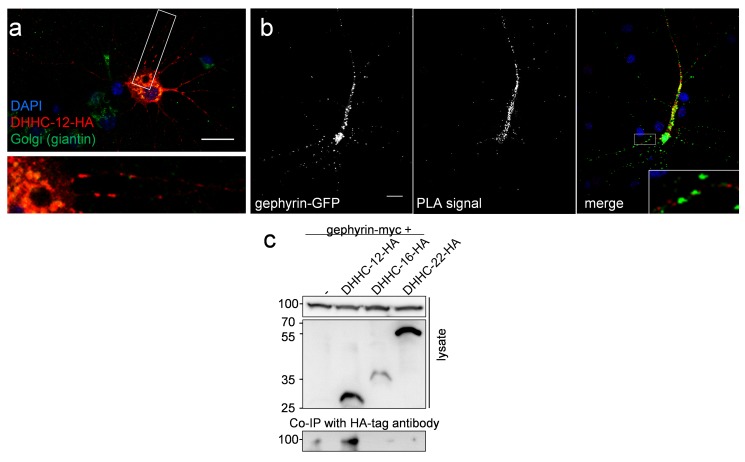
Subcellular localization of the DHHC-12/gephyrin interaction.(a) Representative image of a primary hippocampal neuron transfected with DHHC-12–HA (red) immunostained together with the Golgi-marker giantin (green). The higher magnification below shows Golgi localization of DHHC-12 in the cell body and in dendrites as vesicle-like structures. (b) PLA dots (red) demonstrate direct interaction of gephyrin-GFP and DHHC-12–HA in cultured neurons. PLA dots in the inset show gephyrin-GFP and DHHC-12–HA interaction outside gephyrin clusters. Scale bars, 20 µm. (c) Co-immunoprecipitation of gephyrin-myc from HEK293 lysates co-expressing HA-tagged DHHC enzymes as indicated with HA-tag–specific antibodies.